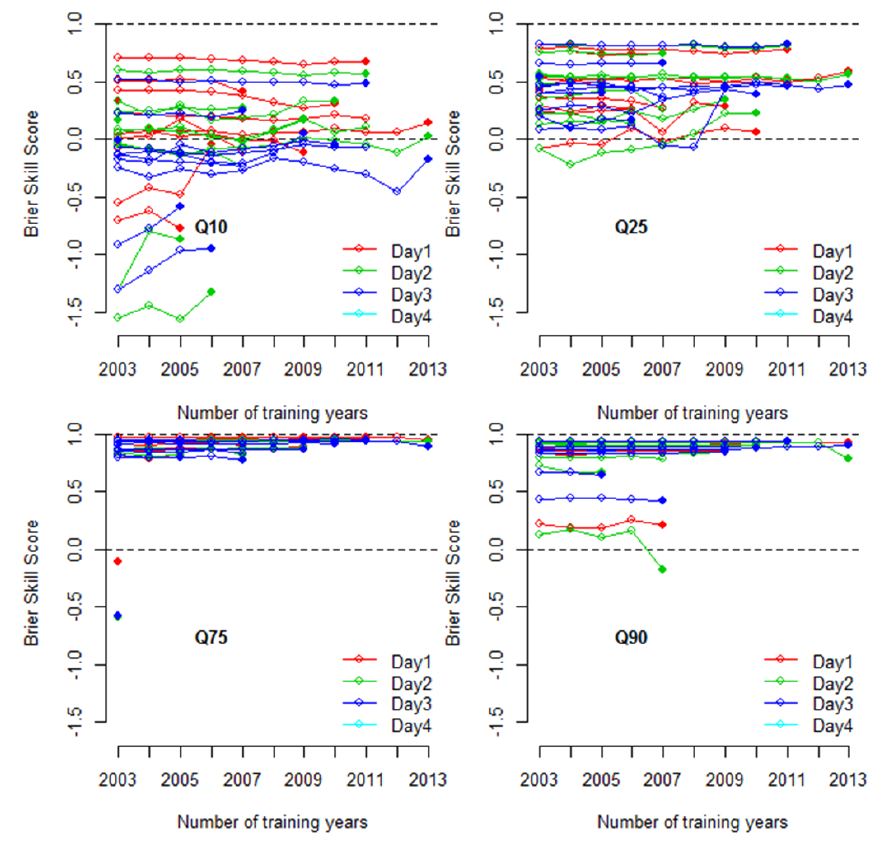
Figure 18. Brier skill score for various forecast years and various sizes of the training data set across different lead times (colors) and event thresholds (plots) for Hardin, IL (HARI2). The filled-in end point of each line indicates the BSS for the forecast year on the x axis with 1 year in the training data set. Each point to the left stands for 1 additional training year for that same forecast